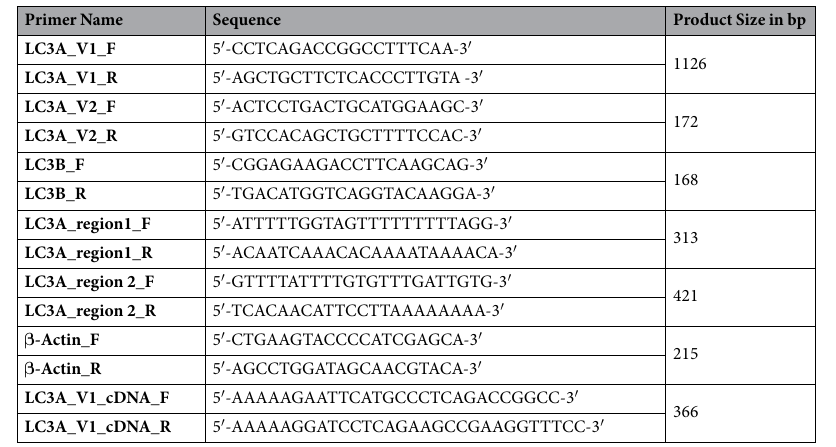
Table 1. Primer sequences for expression, cloning and bisulfite sequencing